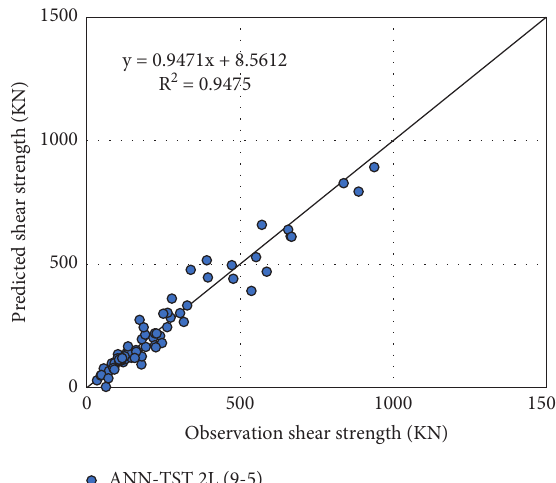
Figure 6: Target (experimental) versus predicted values of shear strength for ANN-TST 2L (9-5) model using testing data.